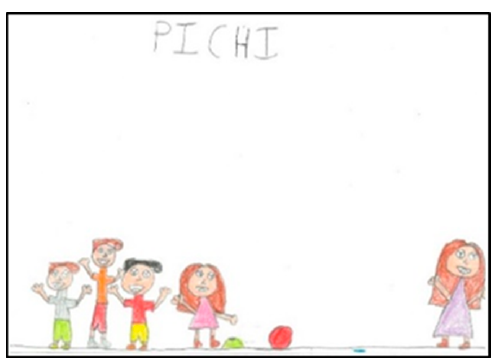
Figure 12. Representation of movement. Rodrigo. 2°B.